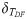
Parameter estimates from the clinical manifestation models.(a) Density estimates of T-cell clearance rate δTDF for models OAS1 (solid green) and OAS2 (dashed green), alongside the assigned value of δTDHF (purple line). (b) Density estimates of T-cell activation rates qTDF and qTDHF for model OAS2. (c) Density estimates of viral infectivity rates βDF and βSIDHF for model ADE. (d) Density estimates of βDF and βSIDHF when the ADE model is fitted to the subset of the data for individuals with a detected viral peak. The median parameter estimate and 95% posterior credible interval (in parentheses) of the difference of the parameter estimates shown in (a-d) are: (a) model OAS1: δTDF−δTDHF 1.1 × 10−7(3.8 × 10−9, 6.5 × 10−7). model OAS2: δTDF−δTDHF: 2.1 × 10−7(7.2 × 10−9, 1.1 × 10−6). (b) qTDHF−qTDF: 1.4 × 10−7(2.8 × 10−8, 3.1 × 10−7). (c) β2o, DHF − βDF: 1.4 × 10−11(9.9 × 10−13, 3.8 × 10−11). (d) β2o, DHF − βDF: 5.2 × 10−11(1.7 × 10−11, 1.0 × 10−10).